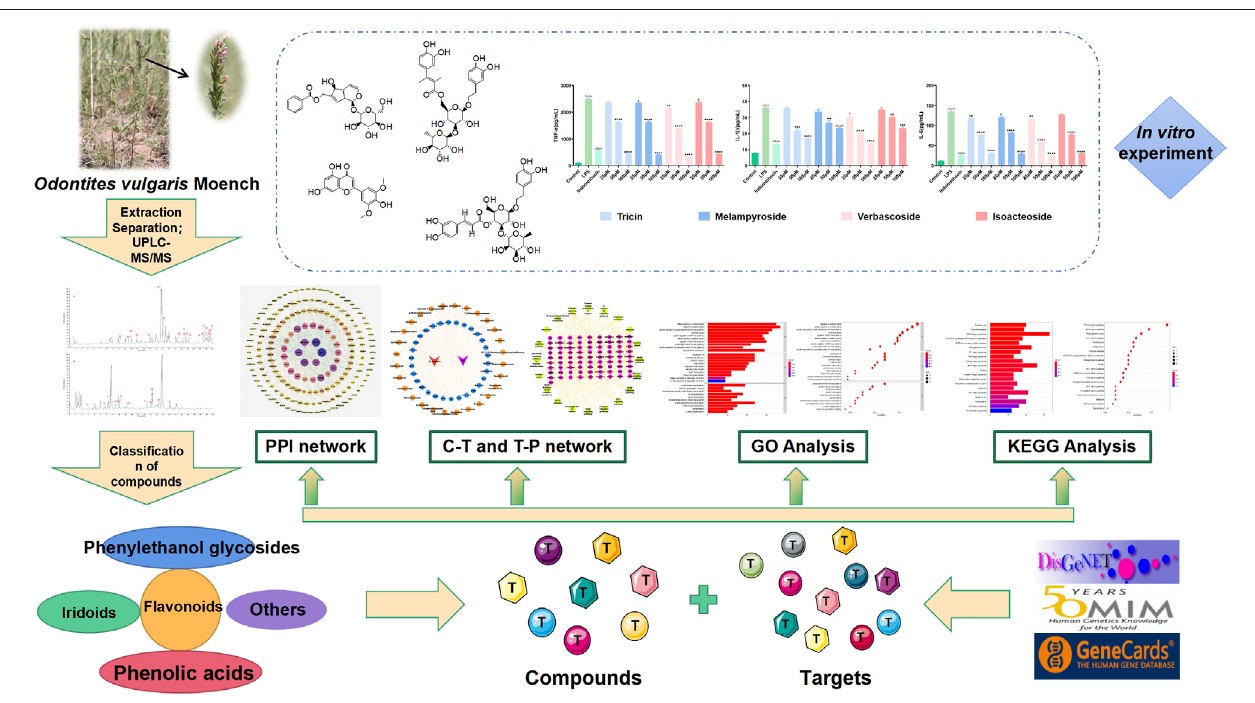
FIGURE 2 | Flow chart of network pharmacological and experimental studies on the effect of O. vulgaris in the treatment of RA.